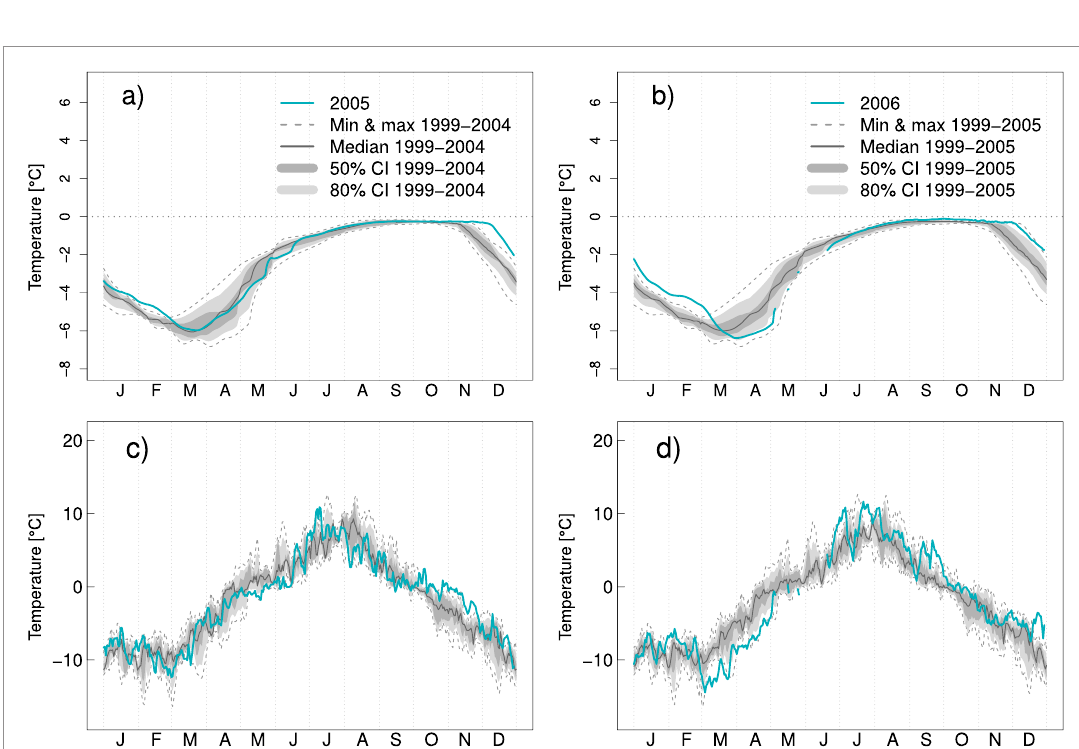
Figure 4. Time series of ground temperature for Juvvasshøe for the years 2005 (a), (c) and 2006 (b), (d): temperature at the top of the permafrost at 2.5 m depth (top) and near-surface ground temperature measured at 0.2 m depth (bottom). The years 2005 and 2006 are shown in blue whereas past minimum, maximum, median, and confidence intervals are shown in